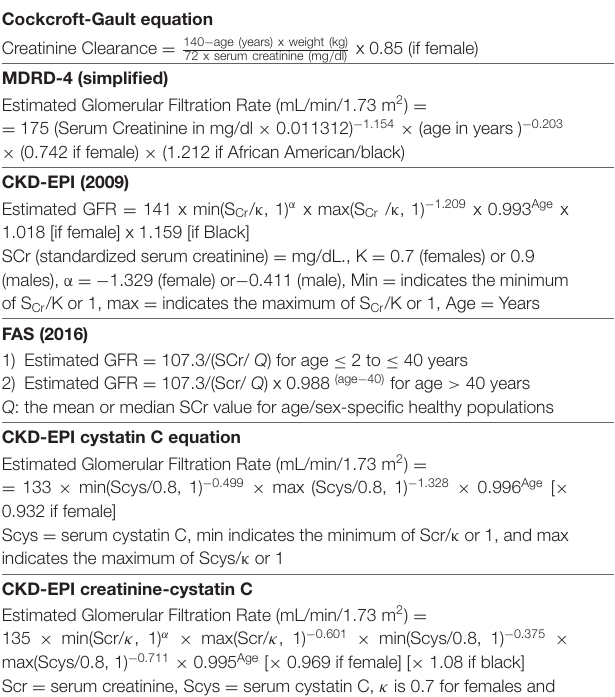
TABLE 1 | Most used creatinine and cystatin C equations to estimate glomerular filtration rate (eGFR). Cockcroft-Gault